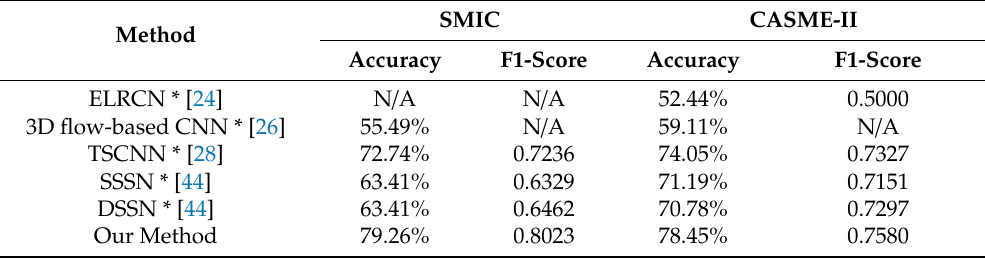
Table 6. Comparison of recognition results between the proposed method and deep learning methods on CASME-II and